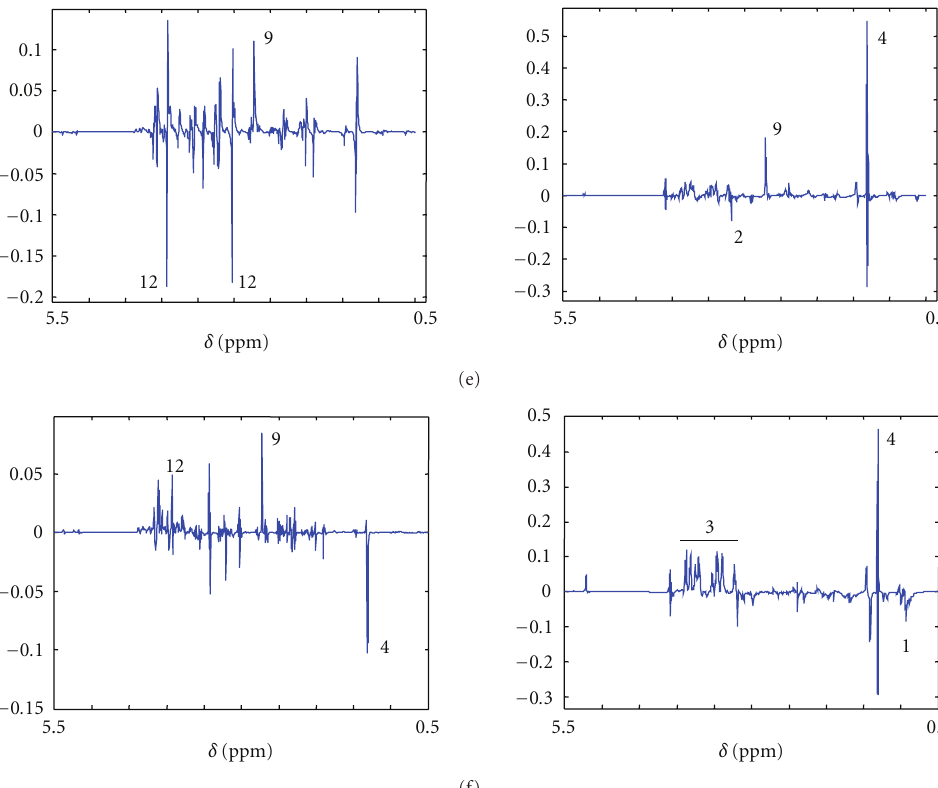
Figure 5: The brain and serum correlation profile depicted by MPCA PC2 loadings plot. The aliphatic region of the spectra is shown. The panels (a–c) are the females and (d–f) are the males. In each set, the left figure is the brain profile and the right is the serum profile. The y -axis in each panel represents the loading axis. The compartmental loadings are obtained by cropping the model loading. (a/d): control, (b/e): early infection, and (c/f): late-infection. Symbols: 10: N-acetylaspartate, 11: sarcosine, 12: creatine, 13: betaine, u: unidentified